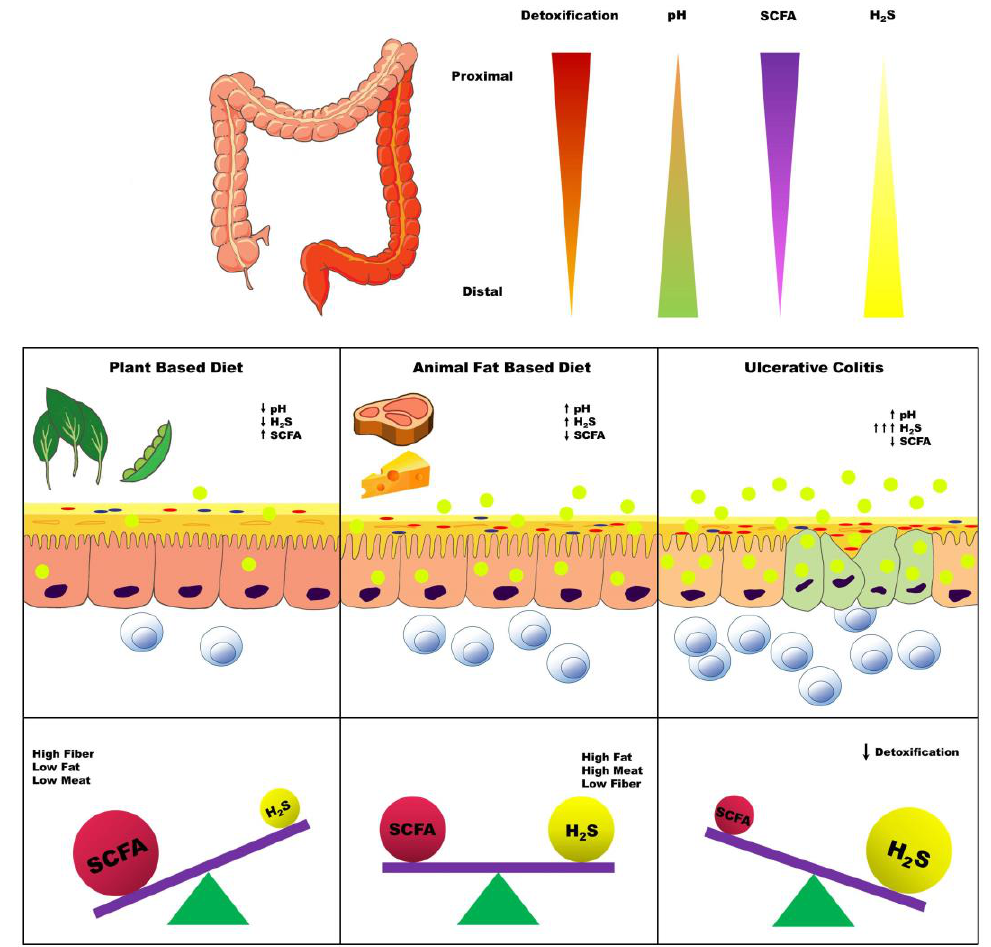
Figure 3. Overview of metabolic milieu and influence of diet in the pathogenesis of ulcerative colitis. Legend: The distribution of inflammation seen with ulcerative colitis is typically greatest in the rectum and extends continuously towards the proximal colon with varying severity. This pattern of inflammation parallels decreasing expression of the host H 2 S detoxifying enzymes, rising pH, and decreasing concentrations of short-chain fatty acids (SCFA). A plant-based diet promotes greater production of SCFA, but not H 2 S. SCFA production decreases in an animal-based diet, while H 2 S production increases; however, there is a sufficient capacity for H 2 S detoxification to prevent epithelial cell damage. Nonetheless, a decreased capacity for H 2 S detoxification results in inflammation, which in turn further exacerbates the gradients of SCFA and H 2 S concentrations along the proximal-to-distal colon axis.